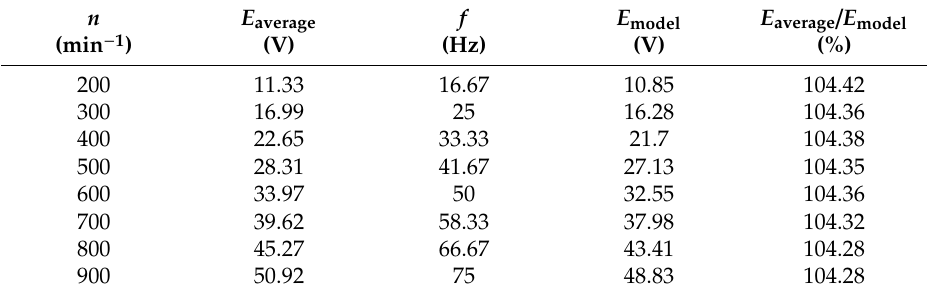
Table 8. Comparison of calculated and measured induced voltages as di ff erent rotation speeds. n